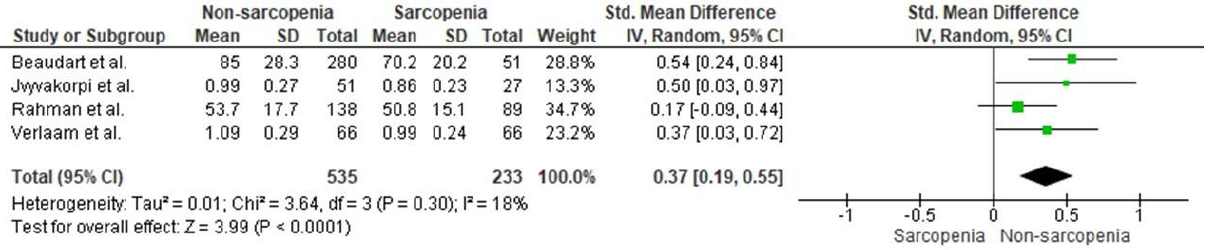
Figure 2. Standard mean differences of protein intake between older adults with and without sar- copenia